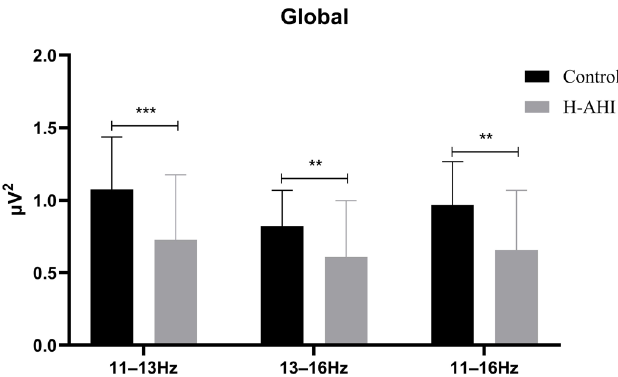
Figure 1. Power spectral density results. Note: **, p < 0.01; ***, p < 0.001. The results of the mixed repeated measures ANOVA showed a significant frequency band main effect, (F (2, 174) = 42.91, p < 0.000, η 2 = 0.33). Post hoc analysis revealed that the PSD of the slow spindle ( M = 0.90 µV, 95% CL (0.81, 0.99)) was significantly higher for the fast ( M = 0.72 µV, 95% CL (0.65, 0.79), p = 0.000) and total spindles ( M = 0.81 µV, 95%